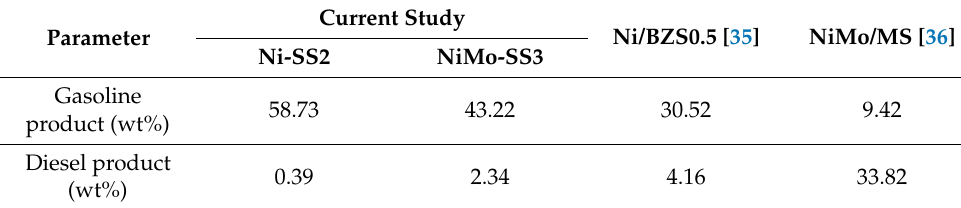
Table 6. Comparison data of liquid yield in the hydrocracking reaction